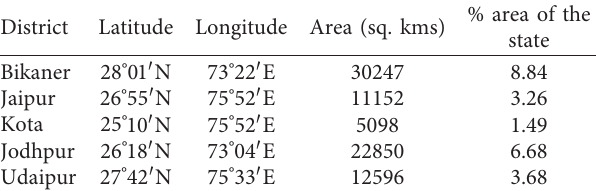
Table 1: The land details of the study area. District Latitude Longitude Area (sq. kms)